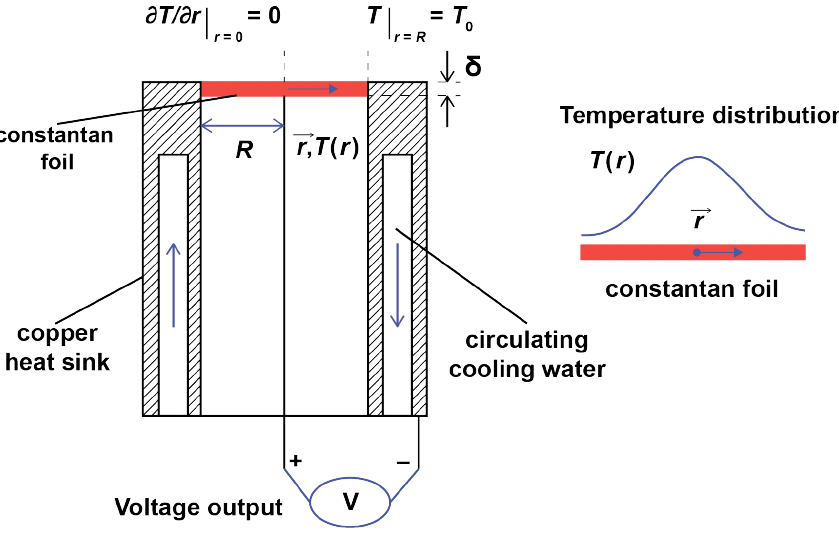
Figure 1. Sketch of Gardon heat flux gauge for convective heat transfer measurements